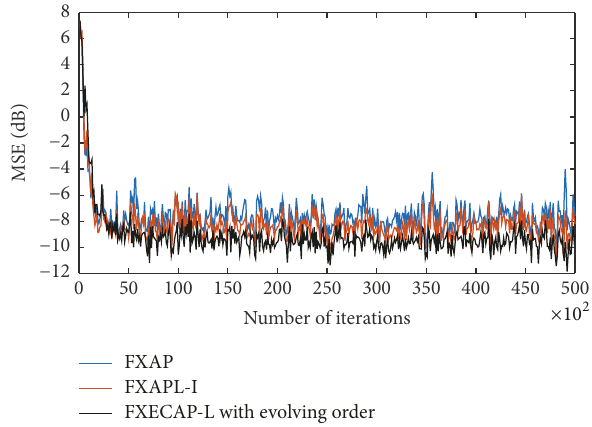
Figure 6: MSE values of the tested AP algorithms for a projection order of 𝐿 = 10 when 𝑏 = 8 bits are used to encode the error.